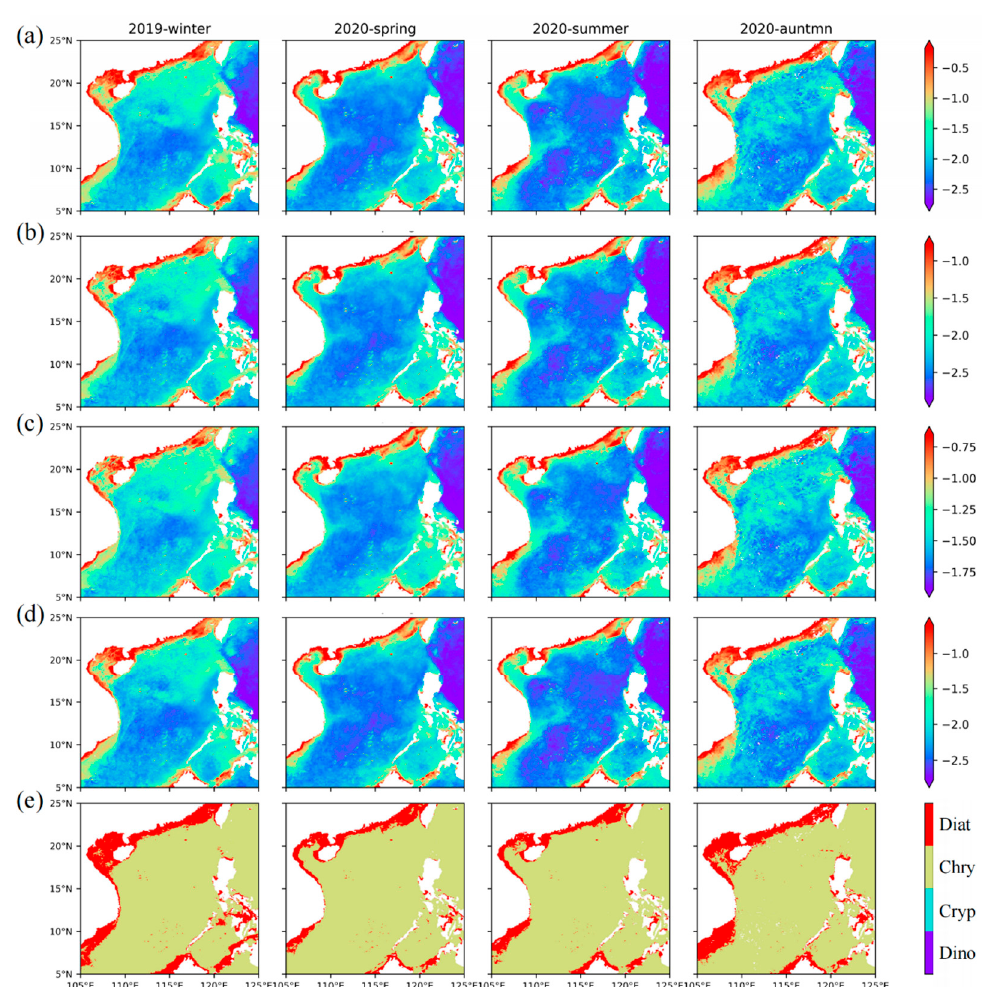
Figure 9. The distribution of diatoms, dinoflagellates, chrysophytes, and cryptophytes in the SCS: seasonal average abundance distribution of ( a ) diatoms, ( b ) dinoflagellates, ( c ) chrysophytes, and ( d ) cryptophytes; and ( e ) the distribution map of the dominant groups. Diat, Chry, Cryp, and Dino indicate the diatoms, chrysophytes, cryptophytes, and dinoflagellates, respectively.